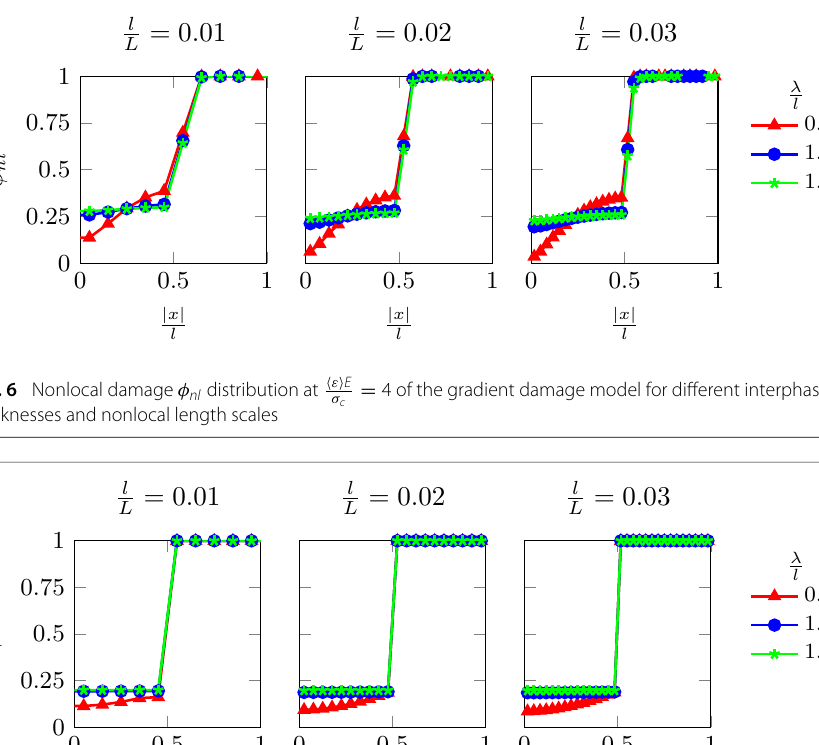
= 4 of the integral averaging damage model for different c